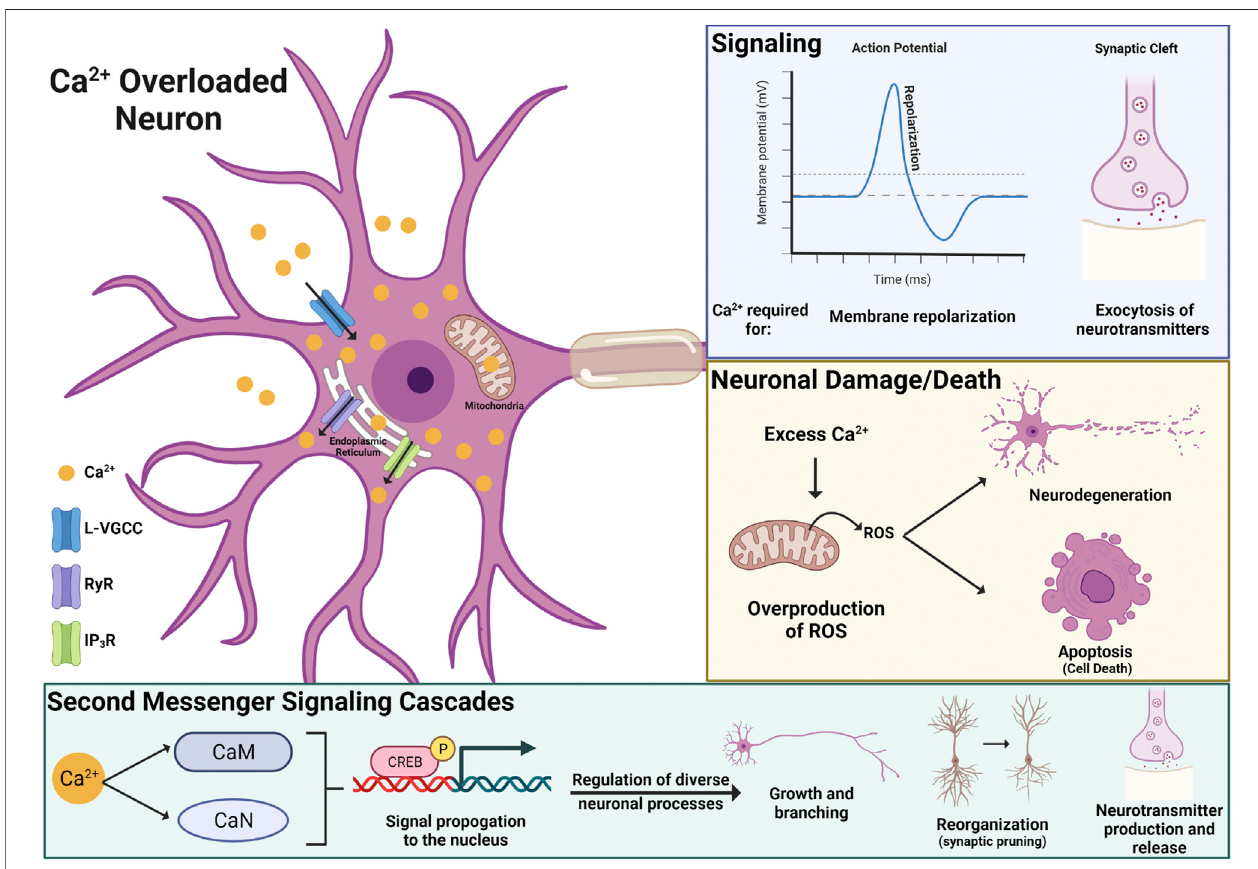
FIGURE 5 | Mechanisms driving PFAS-induced neurotoxicity include direct mechanisms, such as disruption of calcium (Ca 2+ ) homeostasis. PFAS-associated Ca 2+ overload in neurons appears to be driven by Ca 2+ in fl ux from the extracellular space, through L-type voltage-gated Ca 2+ channel (L-VGCC), and intracellular Ca 2+ storageorganelles(mitochondriaandendoplasmicreticulum), via inositol1,4,5-triphosphatereceptors(IP3R)andryanodinereceptors(RyR).Super fl uousCa 2+ can disrupt neuronal signaling, induce oxidative stress leading to neuronal cell death, and disrupt Ca 2+ dependent second messenger signaling cascades (CaM: calmodulin, CaN: calcineurin) that regulate diverse neuronal cell processes, including growth, reorganization, and the production and release of neurotransmitters.